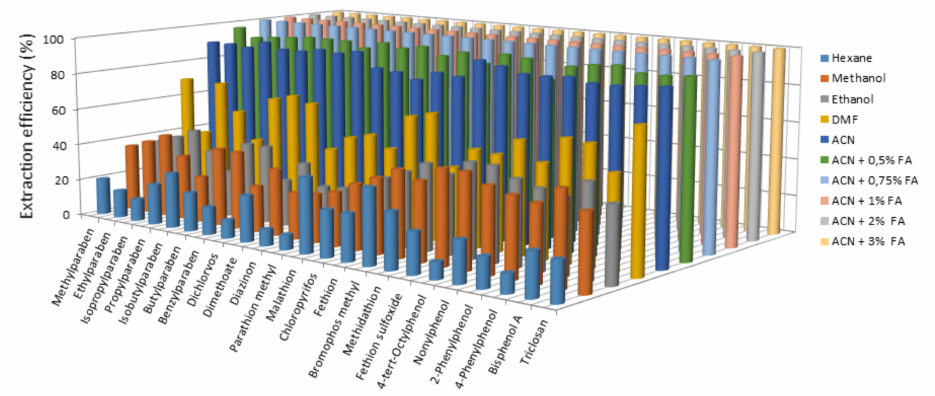
Figure 2. Influence of the solvent on the extraction of endocrine disrupting chemicals from dairy